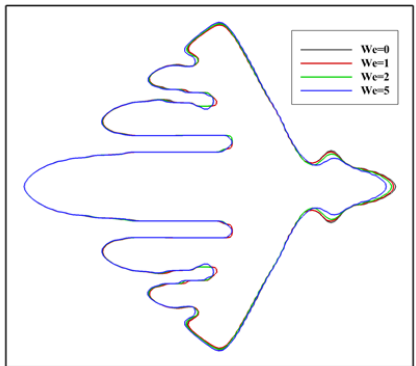
Figure 2. Quantitative study of the flow effect on the growth of the two main branches in the horizontal direction. The ratio between the averaged tip velocities with and without fluid flow is chosen as the measure. The two lines are the relative growth rates of the two branches at different inlet flow velocity.